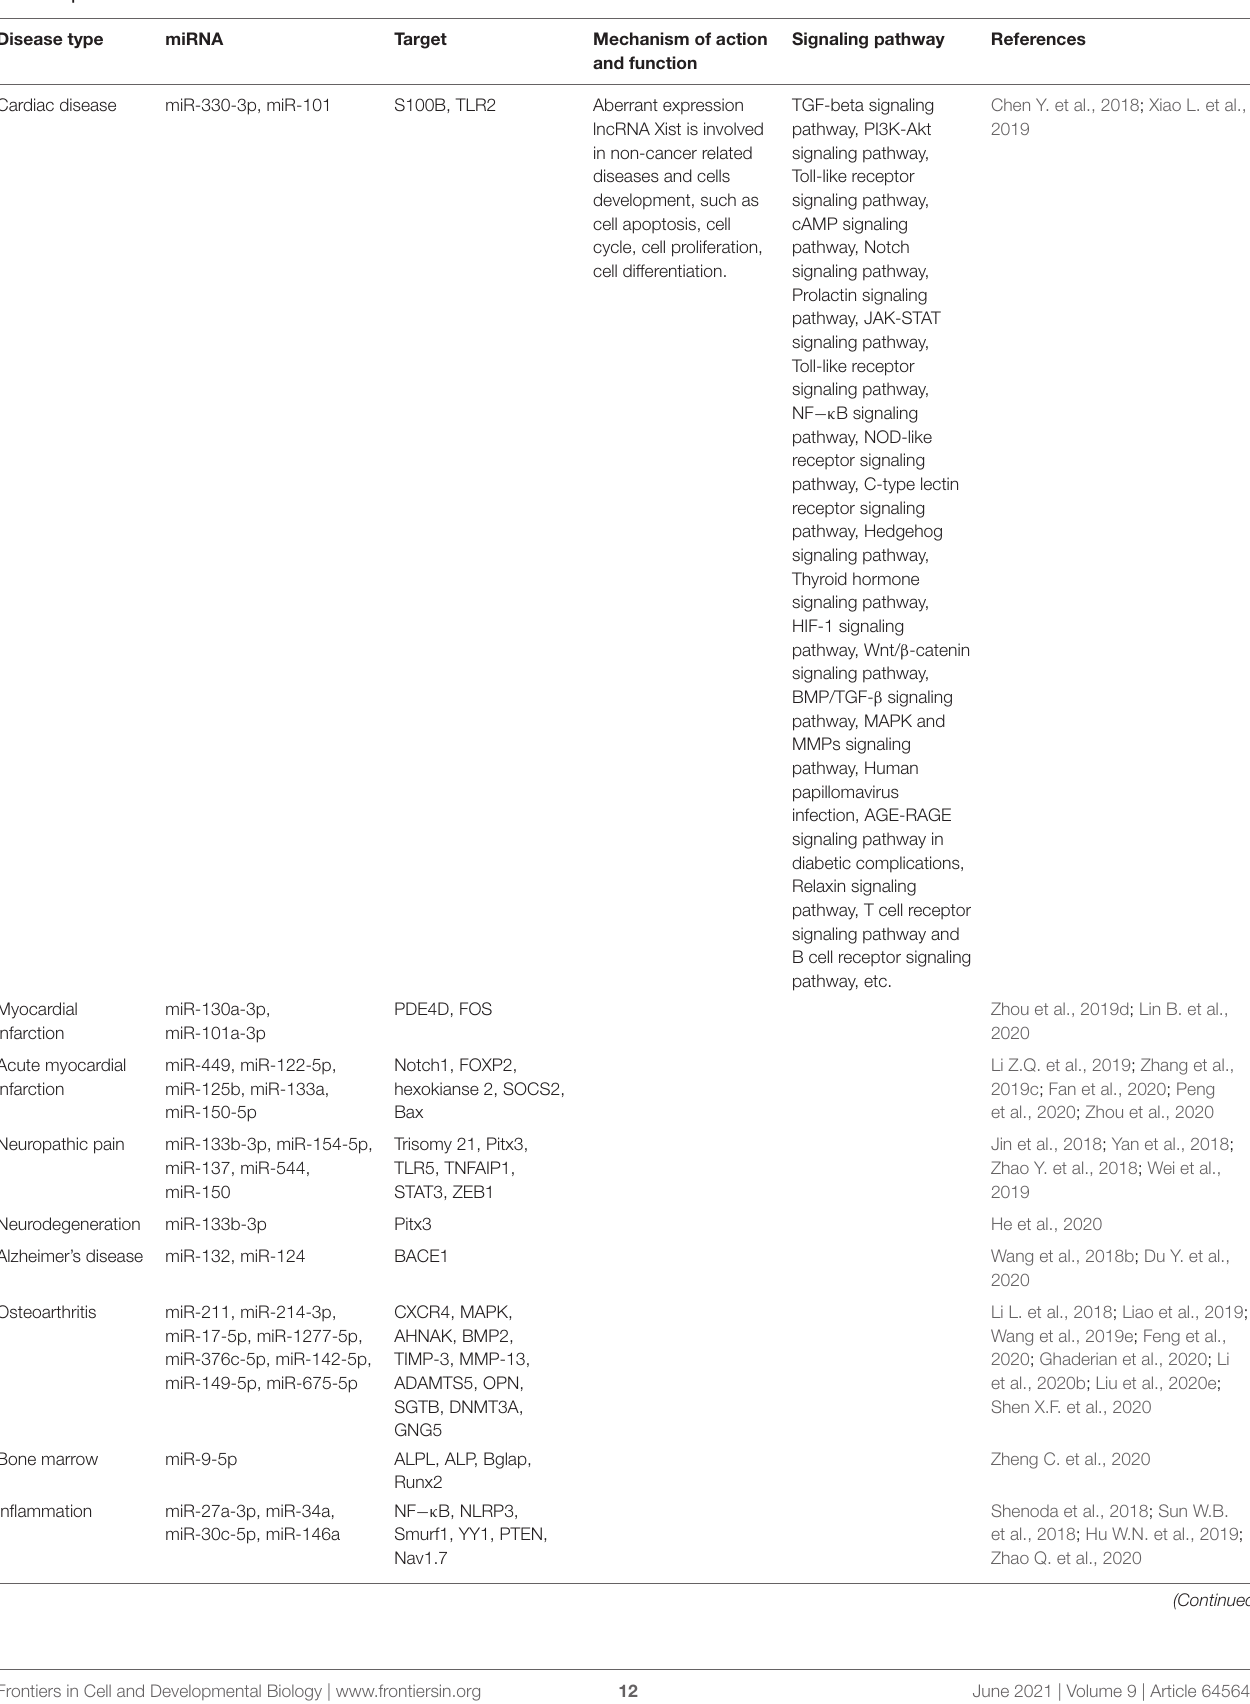
TABLE 2 | LncRNA Xist and miRNA in non-cancer related